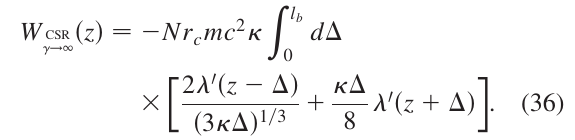
ffiffiffiffiffiffiffiffiffiffiffiffiffiffiffiffiffiffiffiffiffiffiffiffiffiffiffiffiffi